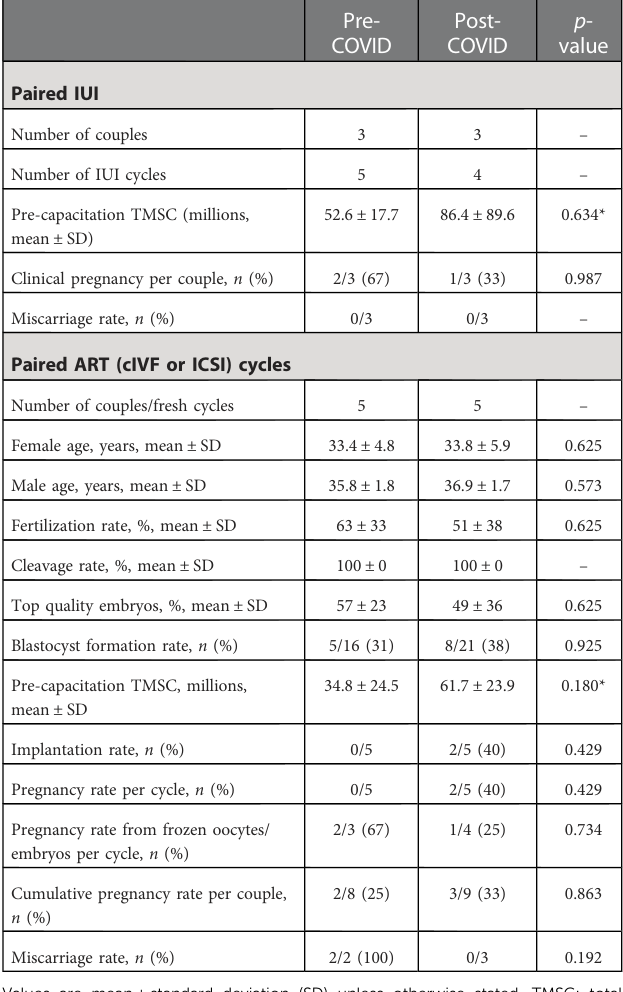
TABLE 3 Embryological, laboratory and clinical outcomes of the fertility treatments performed before and after recovering from COVID-19 disease of the male partner.